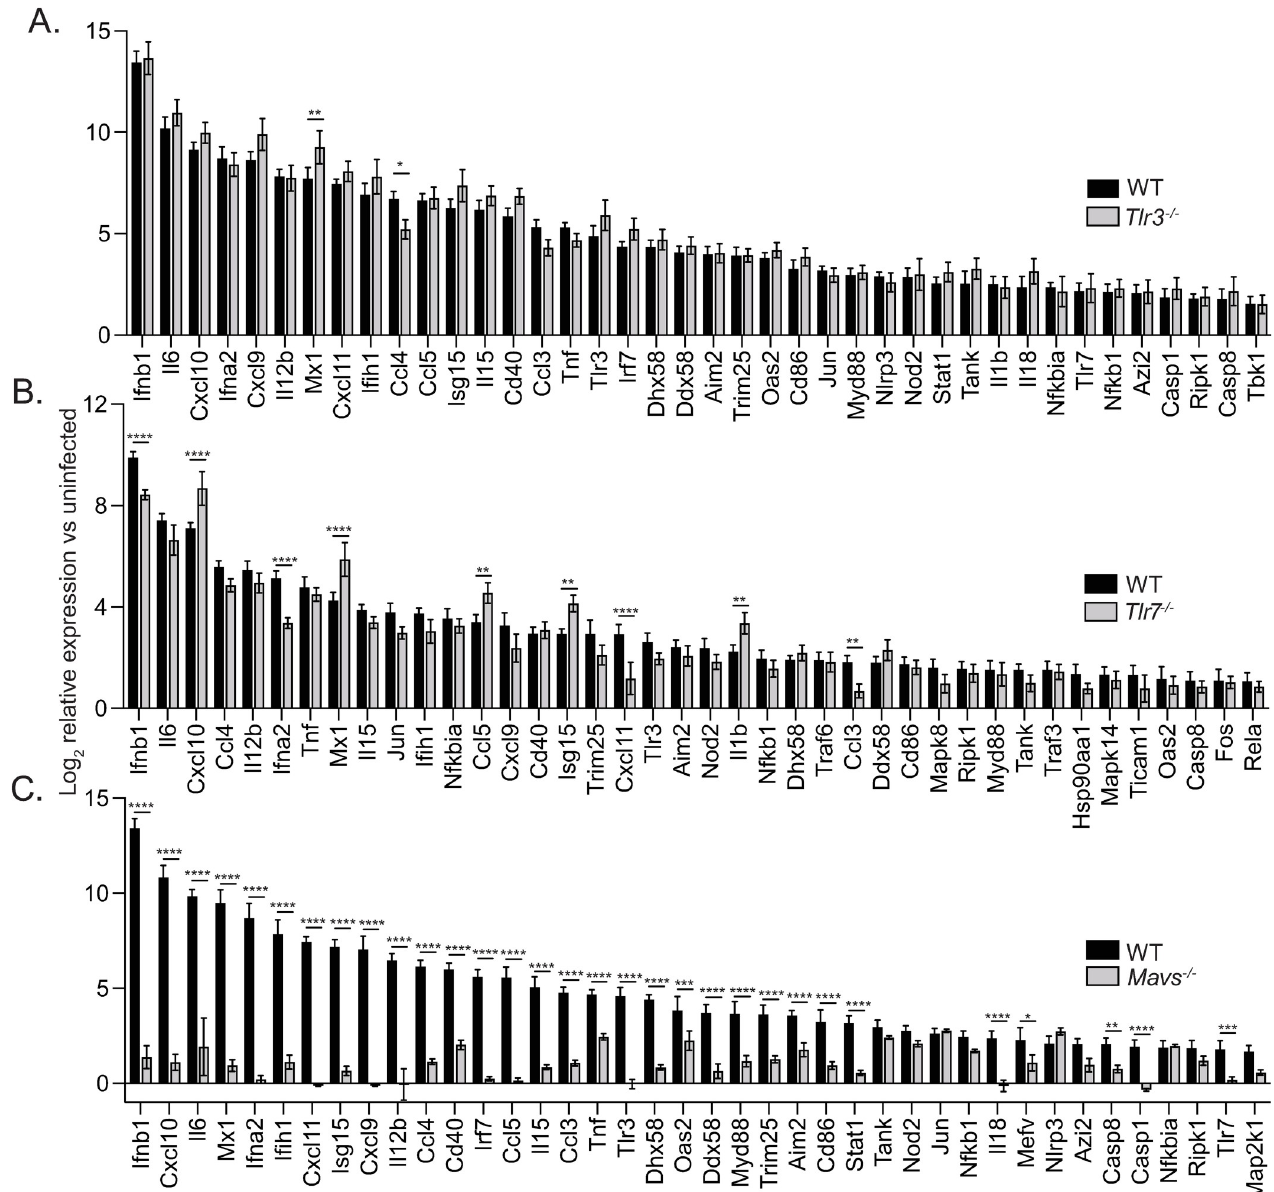
Fig 2. Microglial response to RVFV infection is dependent upon MAVS and independent of TLR7 and TLR3. Primary microglia derived from WT or Tlr3 -/- (A), Tlr7 -/- (B) or Mavs -/- (C) mice were infected with RVFV MP-12. The relative expression of 40 antiviral response genes with the highest fold change in WT cells are shown as the mean log 2 fold change in infected versus uninfected cells, +/- SD. � p < 0.05, �� p < 0.01, ��� p < 0.001, ���� p <